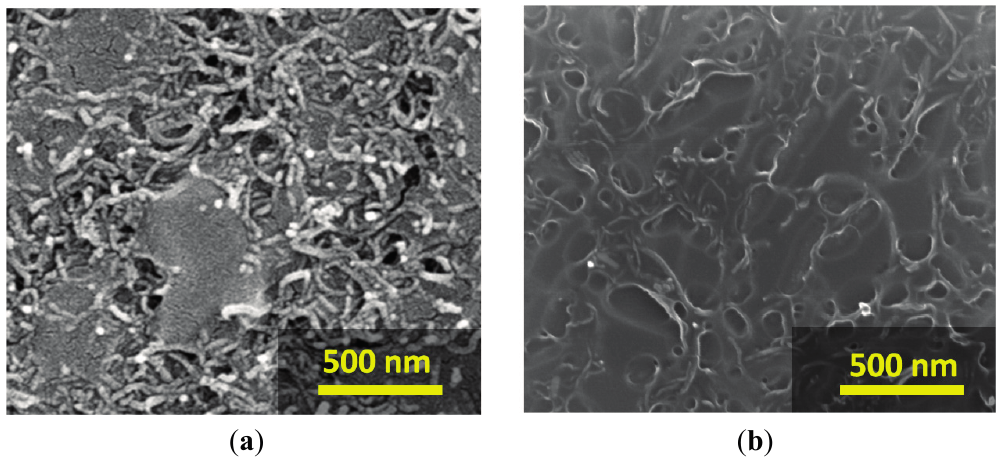
Figure 5. SEM images of surface morphology: ( a ) the DPLs sensor and ( b ) the BSL